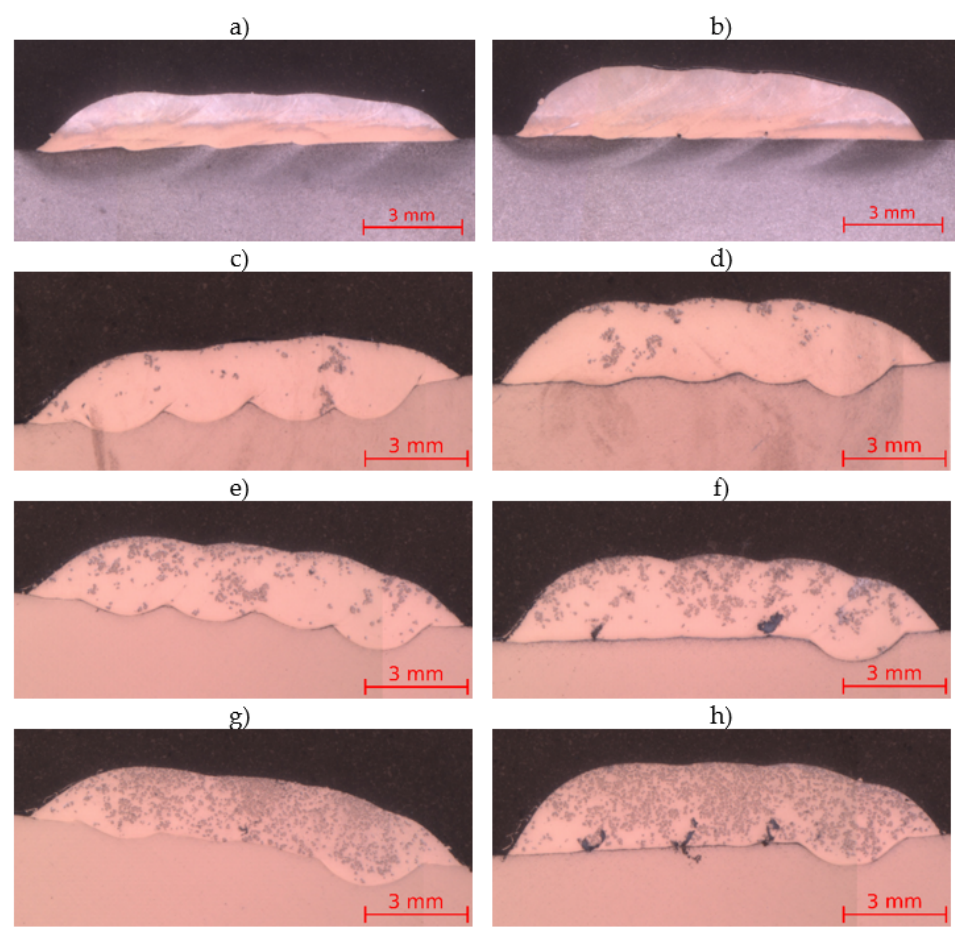
Figure 4. The laser cladded Inconel 625/TiC coatings macrostructures ( a ) I-01, ( b ) I-02, ( c ) M-01, ( d ) M-02, ( e ) M-03, ( f ) M-04, ( g ) M-05, ( h ) M-06 (coatings designation according to Table 3).